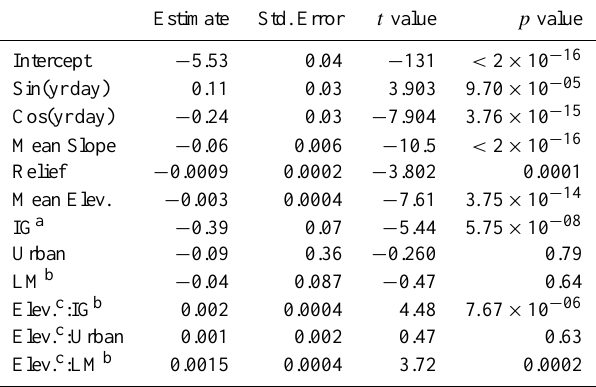
Table 4. Summary of the model from stepwise selection of predic- tors of log p CO 2 in stream water based on geomorphic variables, land cover classification and year day. The coefficient (Estimate) for the three land cover classes shown are expressed as differences from the Arable land cover class (not